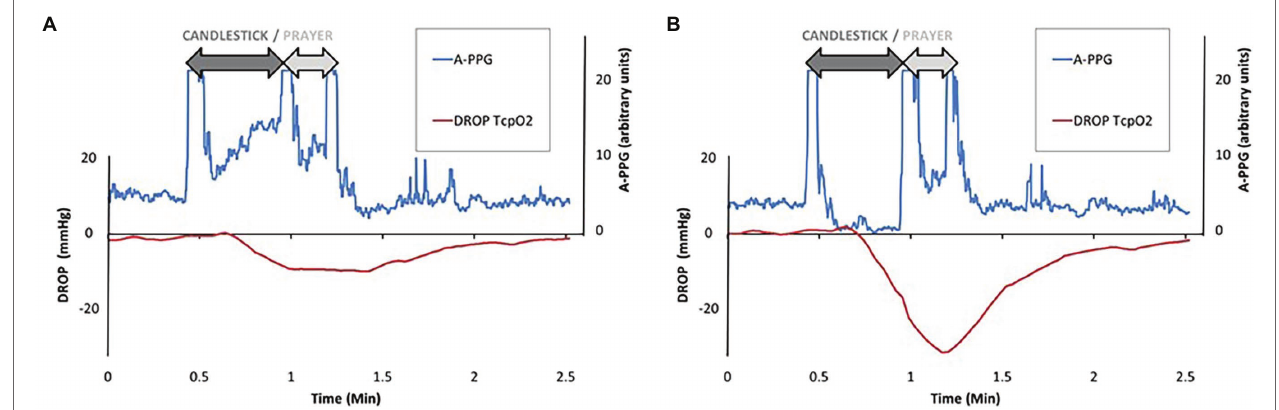
FIGURE 3 | Recordings of a patient with unilateral left symptoms. Note that raw values are for pulse amplitude of photo-plethysmography (A-PPG) and are expressed in arbitrary units. As shown, pulse amplitude increased on the right arm (left panel “ A ”) while it decreased on the left arm (right panel “ B ”) during the candlestick position. As a consequence, the DROP value was lower on the left than on the right side. Note that, due to the relatively slow half-time response for PtcO2, the minimal DROP value ( − 29 mmHg) is observed while the pulse amplitude is already restored on the left side.